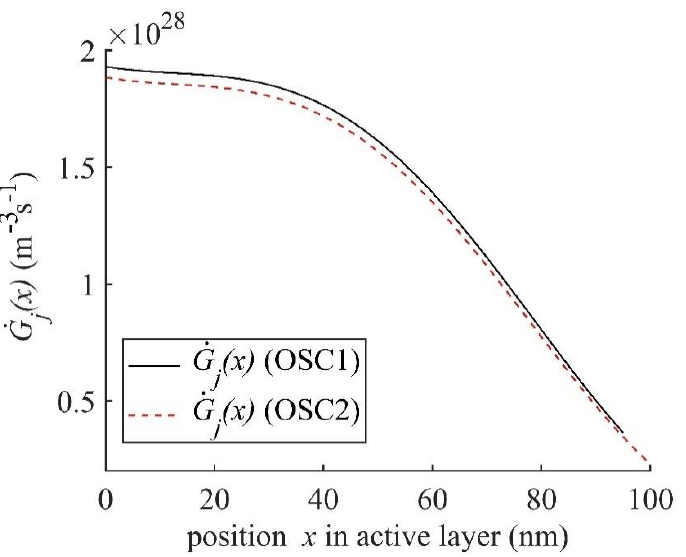
Figure 8. 𝐺̇ 𝑗 (𝑥) plotted as a function of the position x within the active layer of optimal thickness L j = 95 nm and 100 nm for OSC1 and OSC2, respectively.